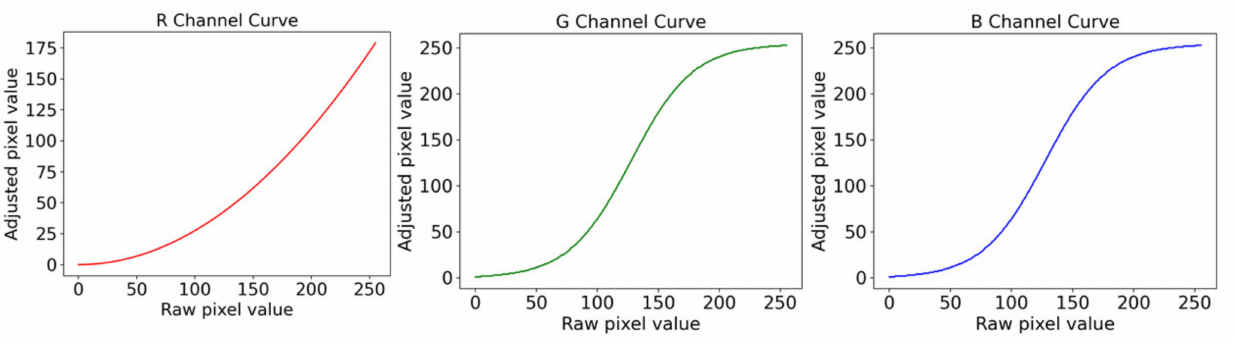
Figure 8. Conversion diagram of RGB in gamma and sigmoid conversion.